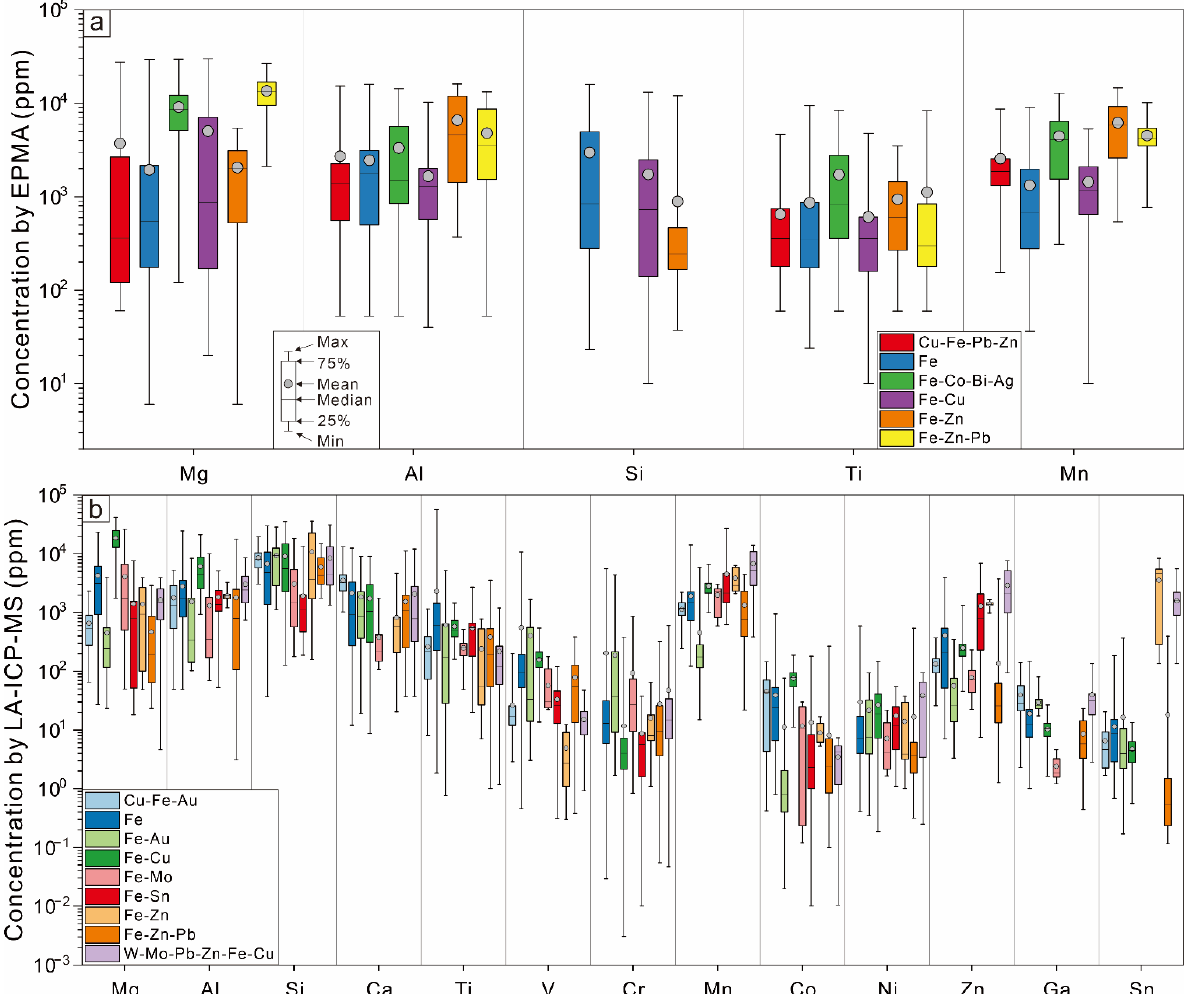
Figure 3. Box and whisker plots showing EPMA ( a ) and LA-ICP-MS; ( b ) trace element contents of magnetite.